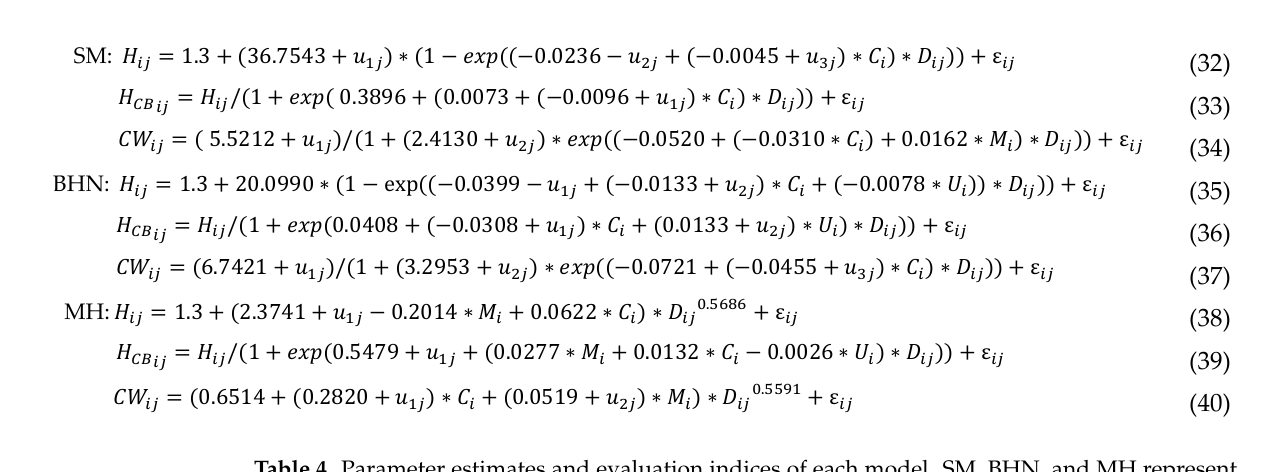
Table 4. Parameter estimates and evaluation indices of each model. SM, BHN, and MH represent Cunninghamia lanceolata , Machilus pauhoi , and Schima superba , respectively. If the letters a, b, and c, are the same, it represents no significant difference between models; otherwise, there are significant differences between models. ** and *** represent significant and extremely significant, respectively.